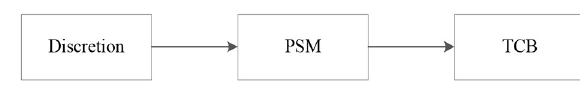
FIGURE 1 | Conceptual